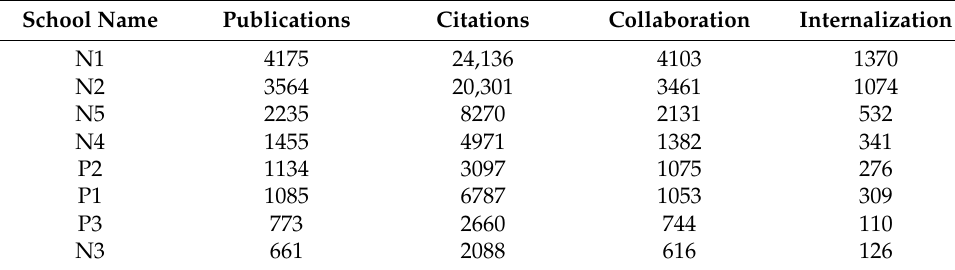
Table 2. Number of publications during 2017–2019.